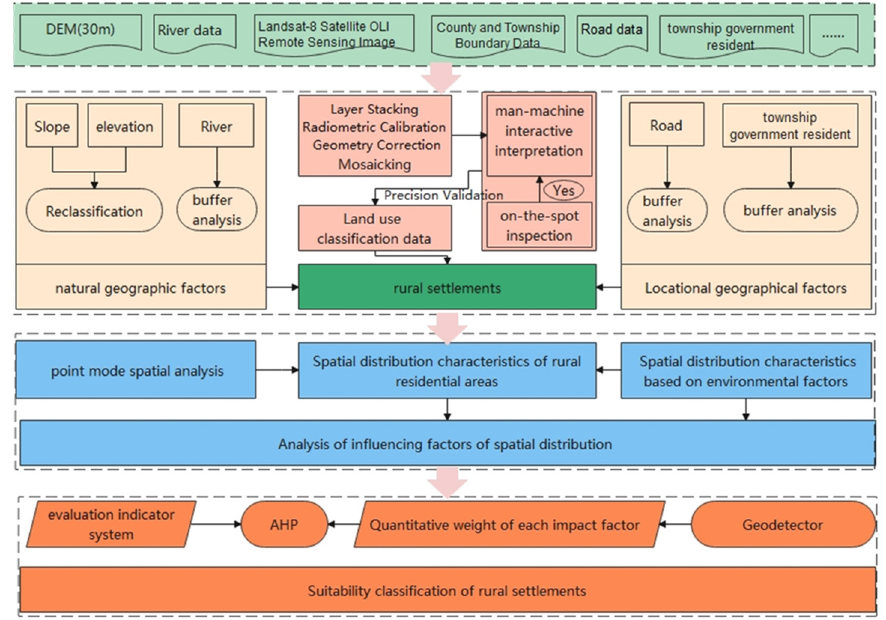
Figure 2. The overall flowchart of the method.